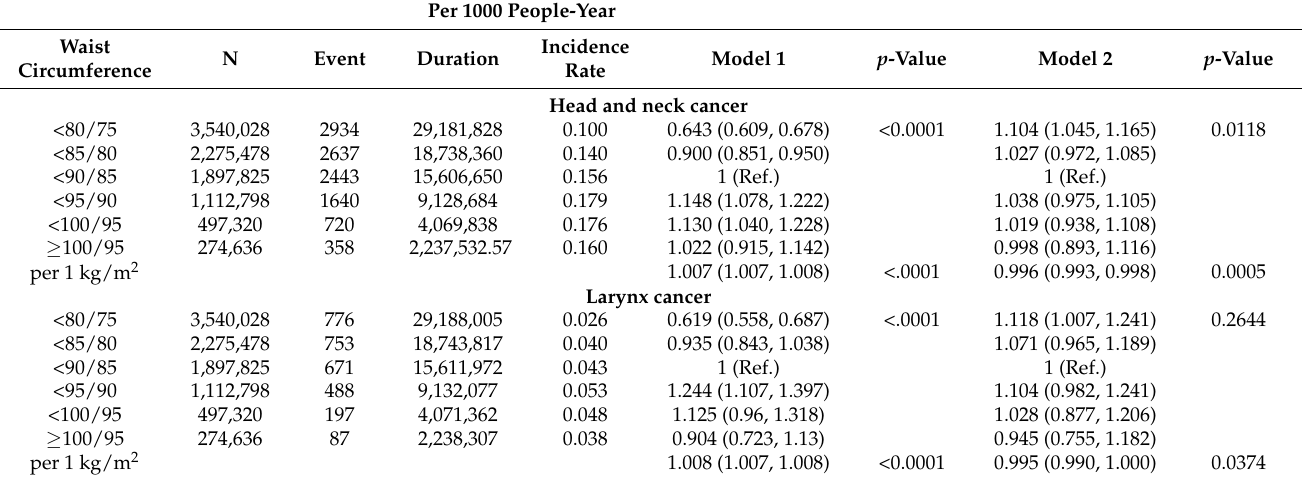
Table 3. Hazard ratios of head and neck cancer and its subtypes according to waist circumfer- ence